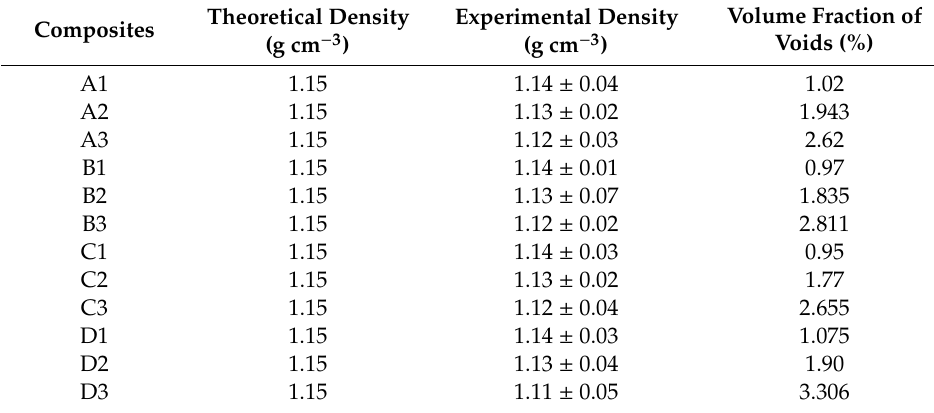
Table 3. Physical properties of the bagasse fibre